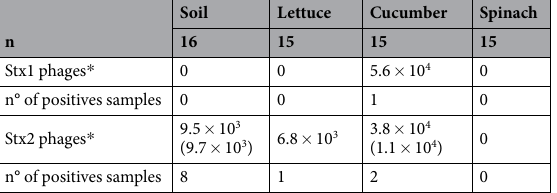
Table 1. Occurrence of Stx1 and Stx2 phages (GC.g − 1 ) in vegetable and soil samples. * Average value of the positive samples. In brackets